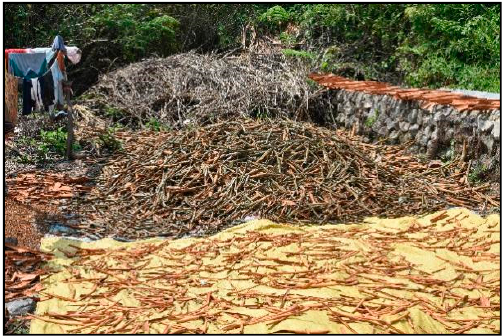
Figure 7. TAKTIK members used the mat to sundry (coordinate: − 2° 14.232 ′ , 101° 30.735 ′ ). Source : documentation of researcher.